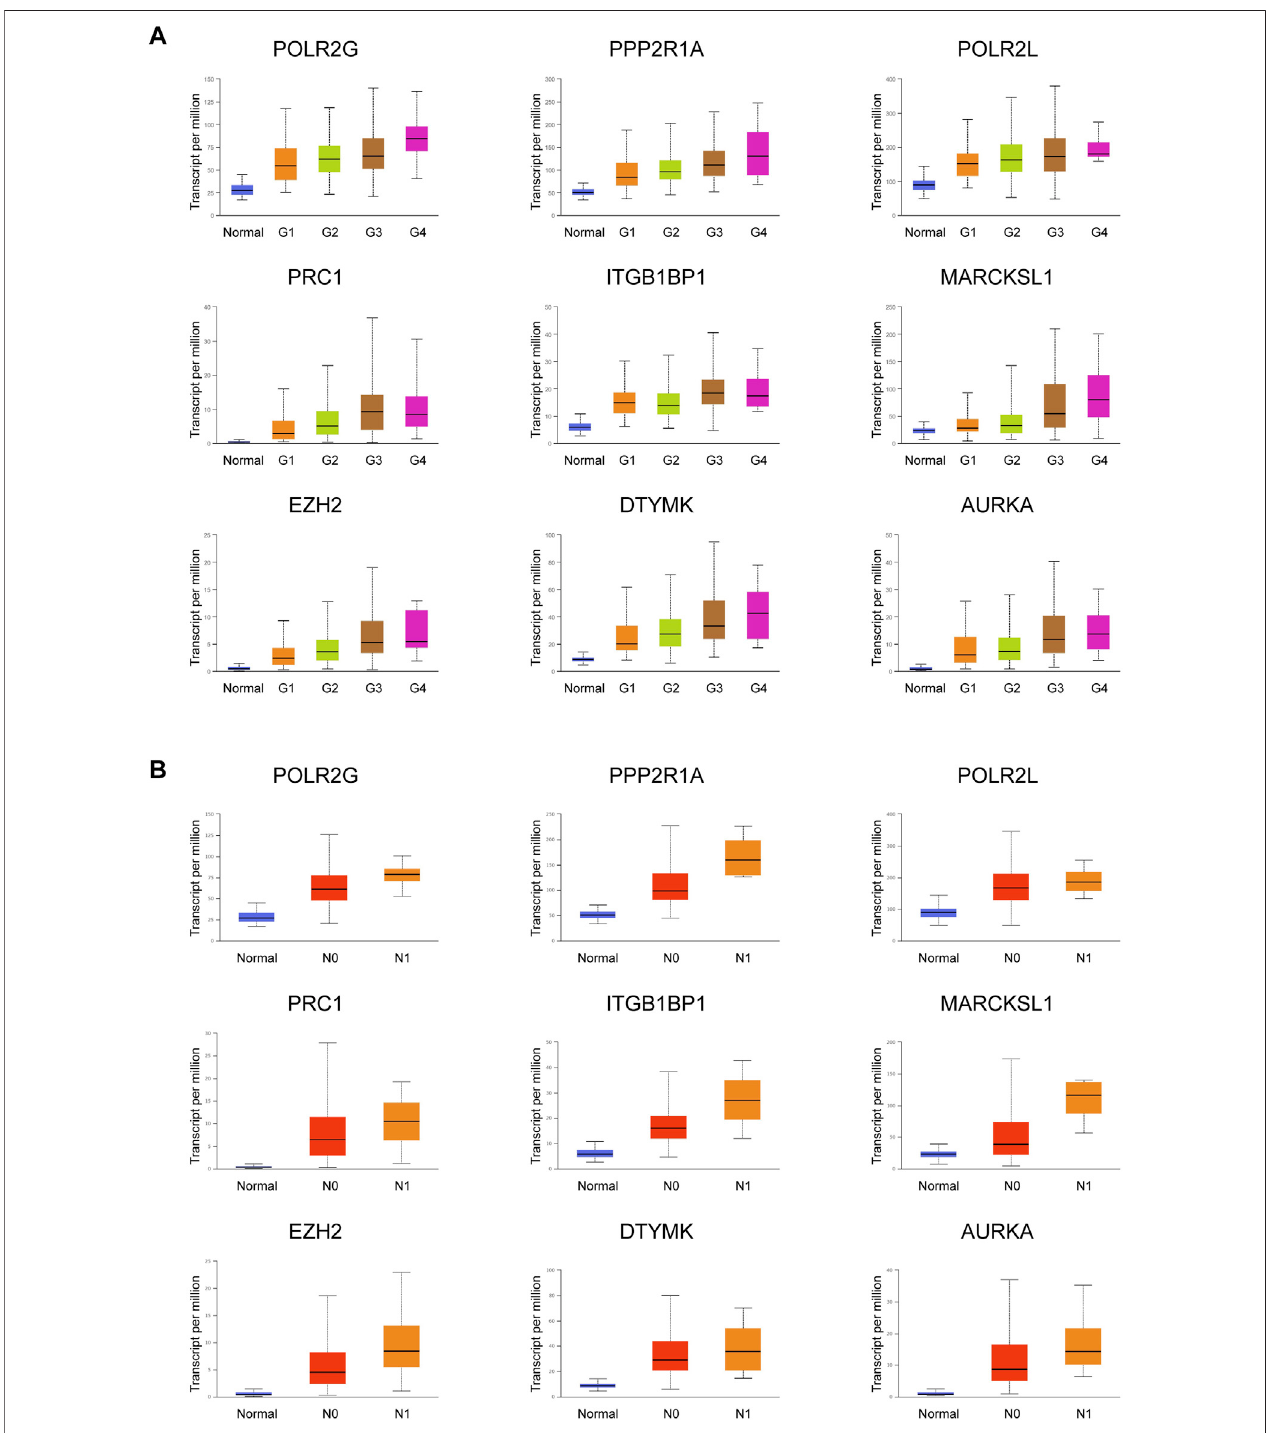
FIGURE4| Expression ofnine important PRGsisrelated totumor grade and nodal metastasis status. (A) ExpressionoftheninePRGsatdifferenttumor grades in HCC patients (n_Normal (cid:2) 50, n_Grade 1 (cid:2) 54, n_Grade 2 (cid:2) 173, n_Grade 3 (cid:2) 118, and n_Grade 4 (cid:2) 12). (B) Expression ofthe nine PRGs at different nodal metastasis statusesinHCCpatients(n_Normal (cid:2) 50,n_N0 (cid:2) 252,n_N1 (cid:2) 4).Thestatisticalsigni fi canceoftherelationshipbetweengenesandtumorgrade/nodalmetastasisstatus was shown in Supplementary Table S8